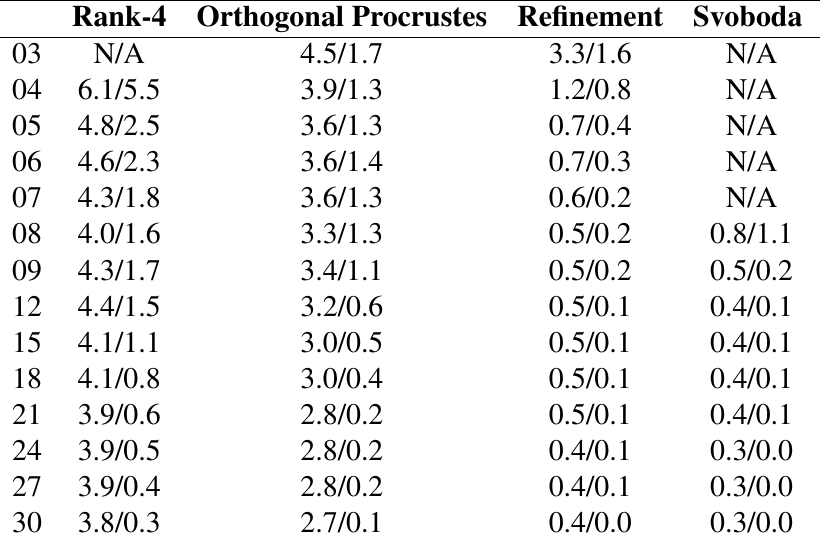
Table 4. Reprojection error (pixel). The first column represents the number of training samples, and the first row gives the methods used for comparison. The refinement method uses the result of Orthogonal procrustes as initial guess, and then applies the proposed refinement method to improve the accuracy. The numbers are listed as “a/s” where a is the average over 100 experiments and s is the standard